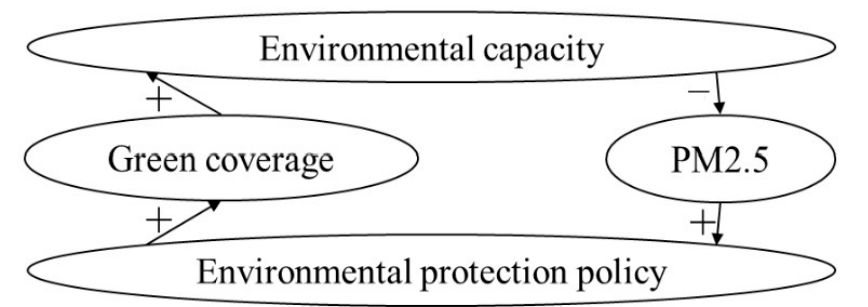
Figure 7. Causality diagram of Beijing urban greening system. The haze in Beijing is affected not only by the harmful emission in the region, but also by the atmospheric circulation and the pollution emission in surrounding cities, especially Tianjin and Hebei. Similar to Beijing, the implementation of national policies and the adjustment of industrial structure have an effect on harmful emissions in Tianjin and Hebei, which indirectly affect the generation of haze in Beijing through atmospheric diffusion and other ways. The causality diagram between sulfur dioxide emissions in Hebei and Tianjin and urban haze in Beijing is shown in Figure